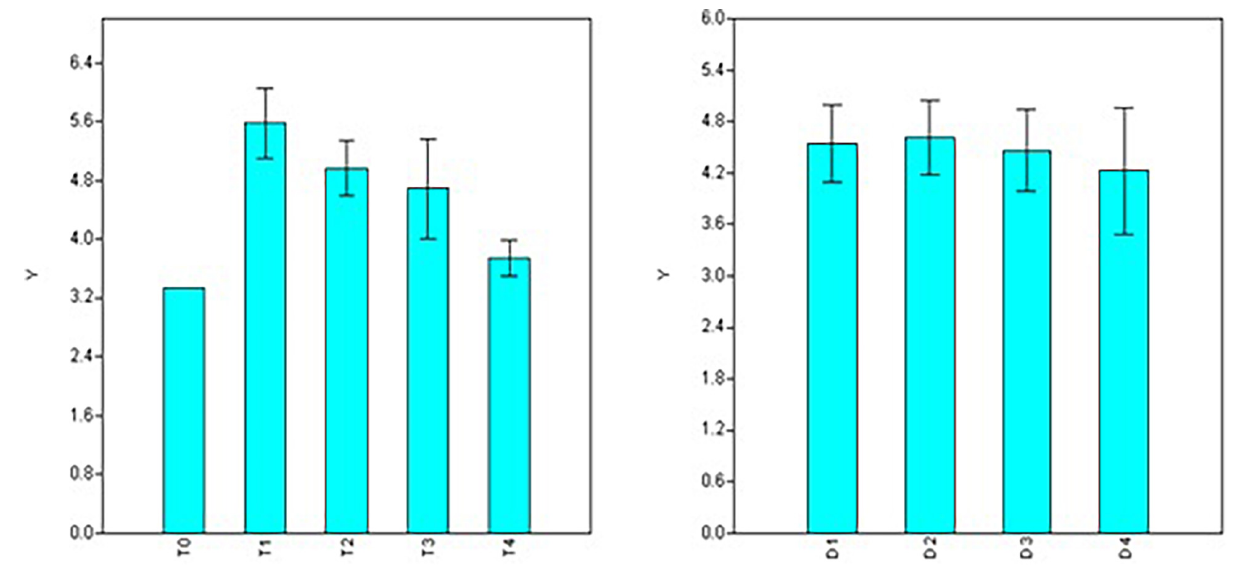
Frontiers in Plant Science |